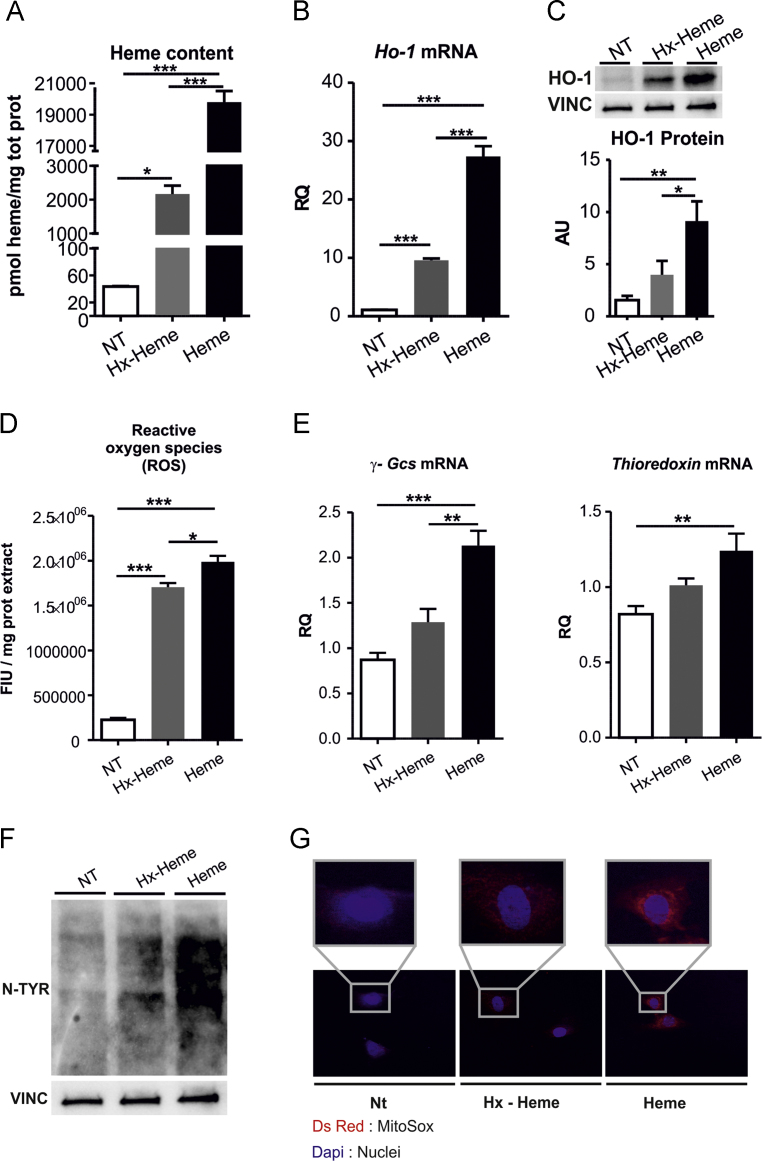
Hemopexin protects H9c2 cells from heme accumulation and ROS production. Data on H9c2 myoblasts cell line untreated (NT) or treated with either 10 µM Hx-heme complex or 10 µM heme for 8 hours, are shown. (A) Heme content. (B) qRT-PCR analysis of Ho-1 mRNA levels. (C) Western blot analysis of HO-1. (D) ROS content and (E) qRT-PCR analysis of γ-Glutamylcysteine synthetase (γ-Gcs) and Thioredoxin mRNA levels. (F) Western blot analysis of N-Tyr. (G) Immunofluorescence analysis of super-oxide radical formation (super-oxide radical was stained with Mito-sox fluorescent probe. Nuclei were stained with DAPI). Results shown are representative of three independent experiments. One-way analysis of variance with Bonferroni post-test analysis was performed. *P < 0.05; **P < 0.01; ***P < 0.001. Values represent mean ± SEM. AU, arbitrary units; RQ, relative quantity; FIU, fluorescence intensity unit.